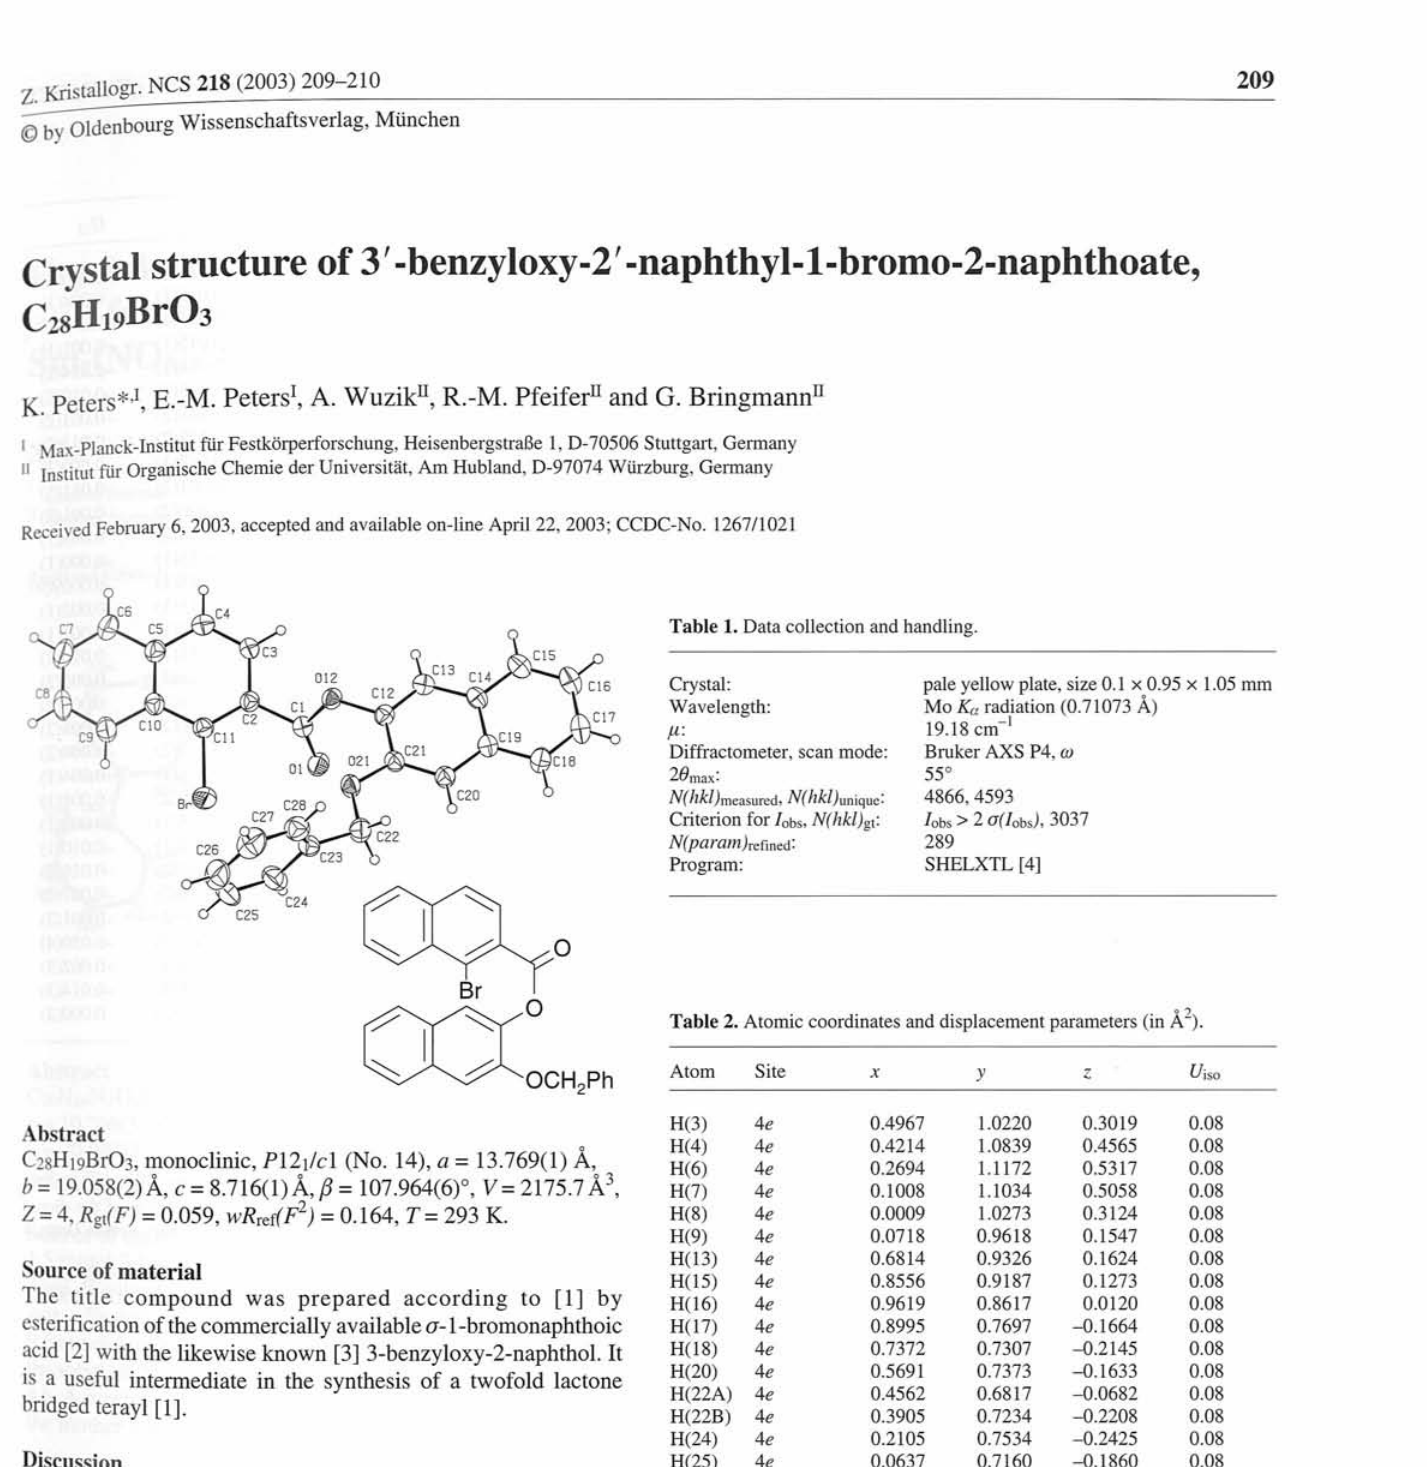
Table 2. Atomic coordinates and displacement parameters (in